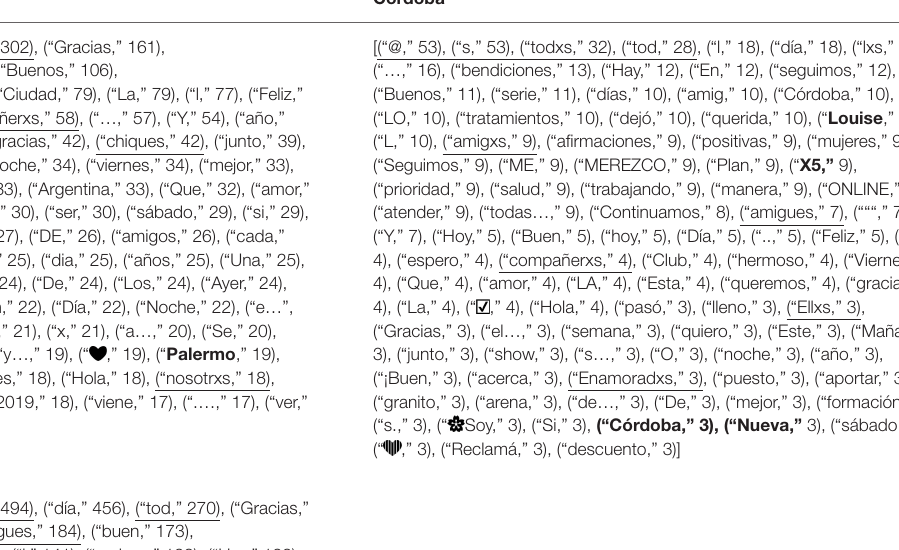
TABLE 3 | Frequency list of single tokens. BA